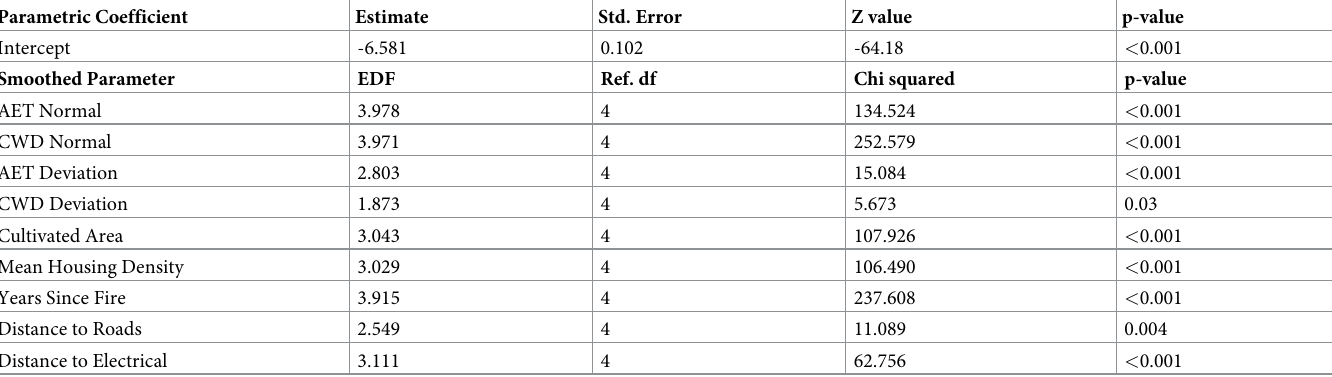
Table 2. Parameter significance of the statewide Generalized Additive Model.